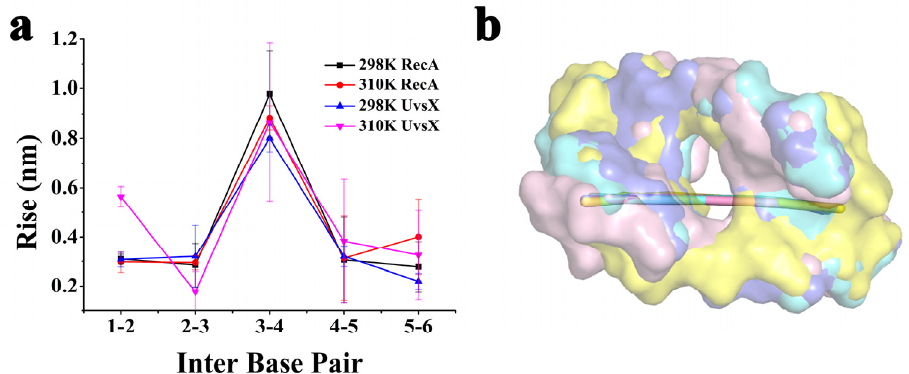
Figure 7. ( a ) DNA rise parameter; ( b ) Diagram of DNA in four systems and the helical axis of the systems. (Cyan for 298 K RecA, purple for 310 K RecA, pink for 298 K UvsX and yellow for 310 K UvsX).